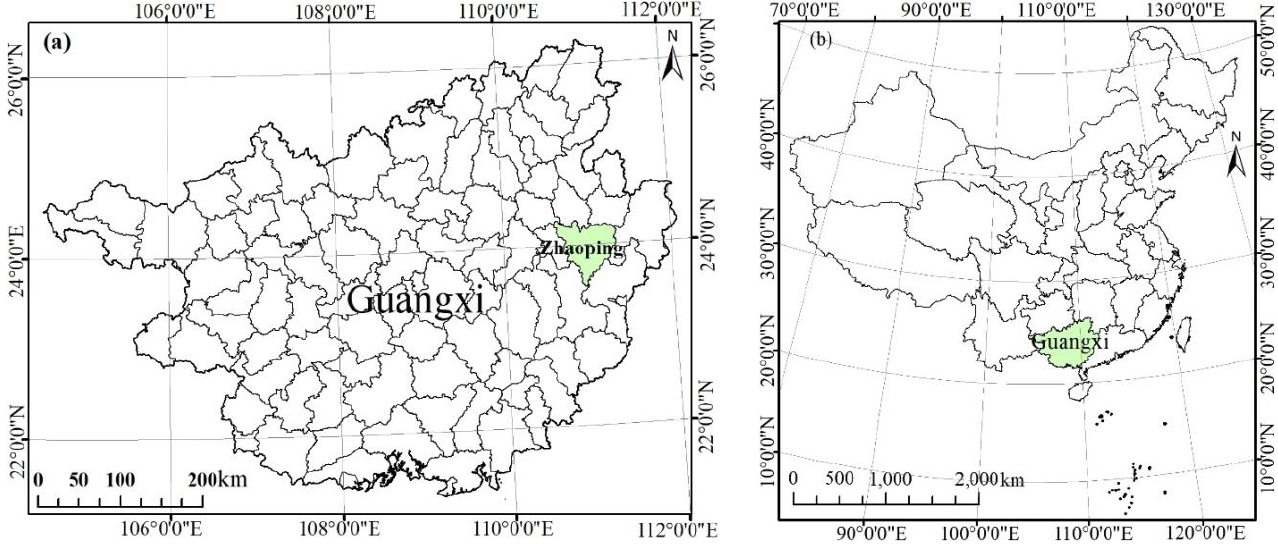
Figure 1. Location of Zhaoping County in Guangxi Province ( a ) and China ( b